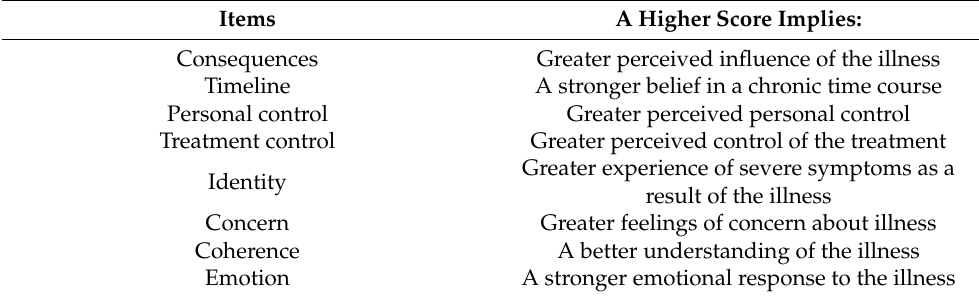
Table 1. Interpretation of the Brief Illness Perception Questionnaire. Items A Higher Score Implies: Consequences Greater perceived influence of the illness Timeline A stronger belief in a chronic time course Personal control Greater perceived personal control Treatment control Greater perceived control of the treatment Greater experience of severe symptoms as a Identity result of the illness Concern Greater feelings of concern about illness Coherence A better understanding of the illness Emotion A stronger emotional response to the